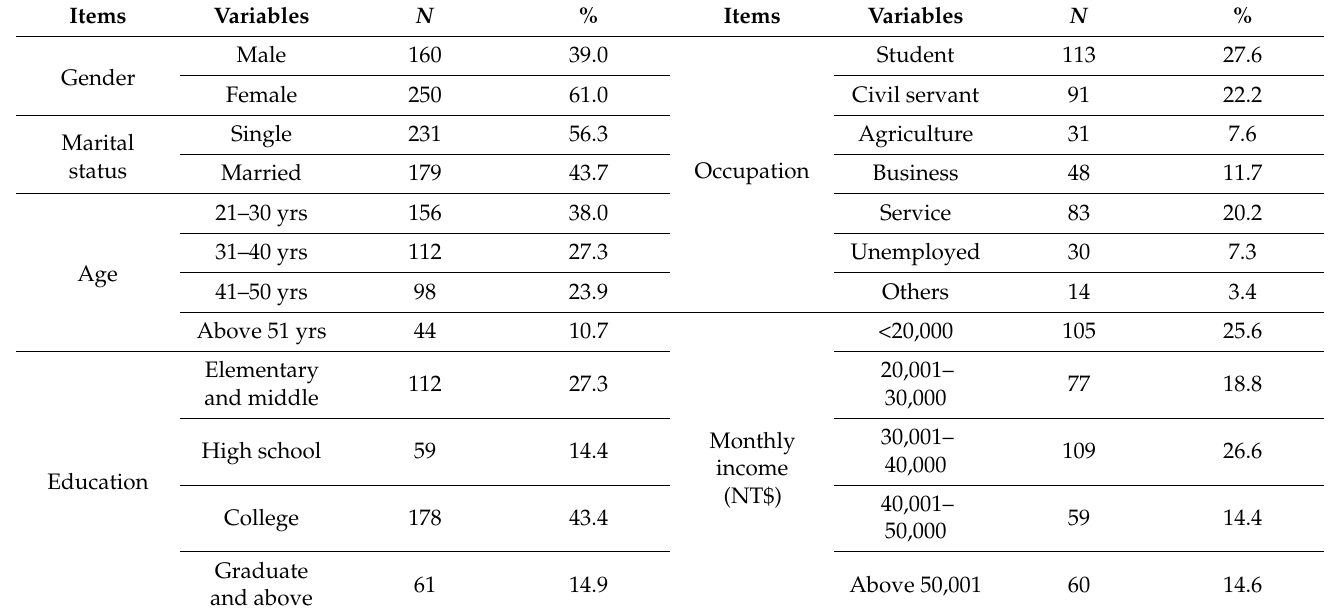
Table 2. Descriptive characteristics of the samples.